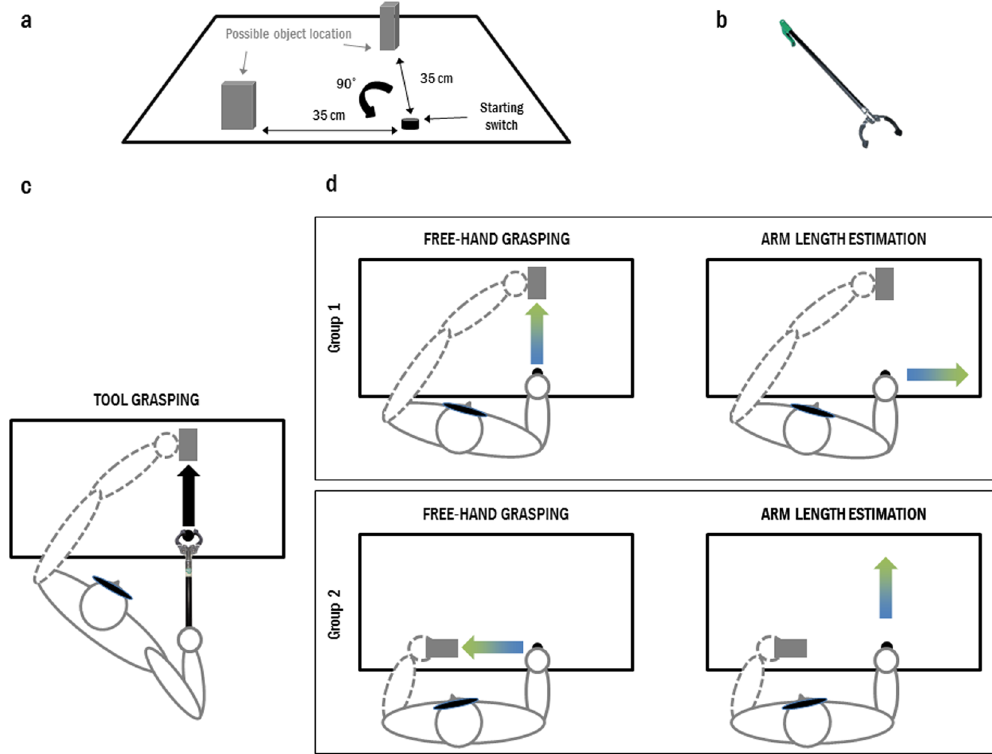
Figure 1. Experimental set-up. ( a ) A wooden object was placed on the table either in front or to the left of the hand starting position. In both cases, the distance between the starting switch and the object was 35 cm. ( b ) Picture of the mechanical grabber used in Experiment 1. ( c ) Tool use was always performed along a sagittal axis. ( d ) Left column: Before and after tool use, upon hearing a go signal, subjects had to reach and grasp the wooden target object with their hand: along the sagittal axis for Group 1, and along the frontal axis for Group 2. Right column: The Estimation task consisted in sliding their index finger for a distance matching the one between their elbow and wrist, along a frontal axis for Group 1, along the sagittal axis for Group 2.